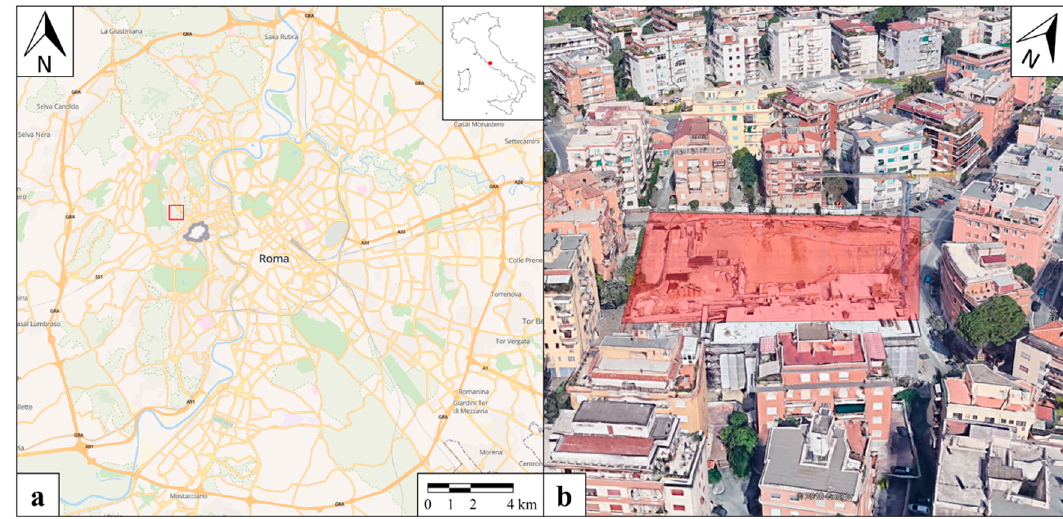
Figure 1. ( a ) City map of Rome, the red polygon indicates the study area; ( b ) 3D model of the Balduina district, the red area shows the construction site where the failure occurred (source: Google Earth ® , 2019).